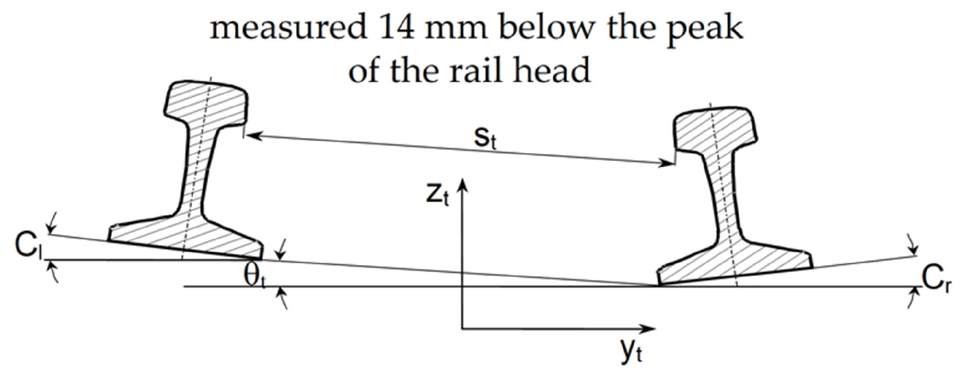
Figure 2. Parameters that define the track geometry: S t —track gauge, θ t — cant, C l , and C r —rail inclination. The description of the track irregularity can be made in several ways,